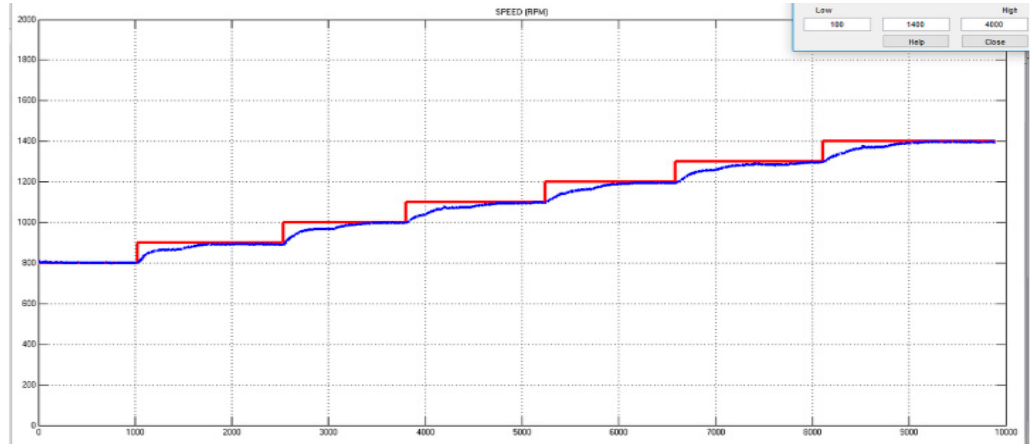
Figure 21. Online monitoring of set speed and the actual speed of motor through a graphical user interface (GUI).